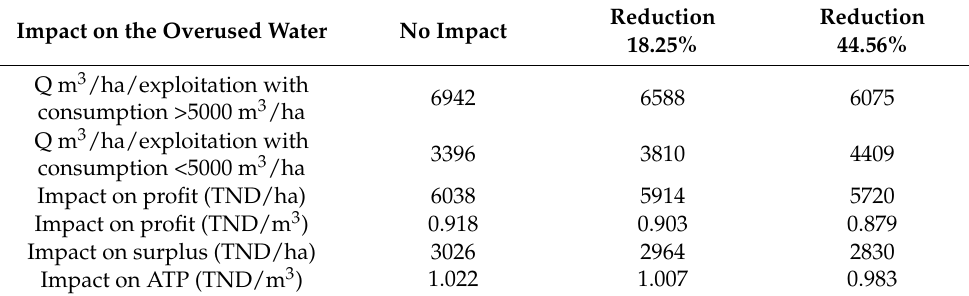
Table 4. Comparisons between different prices.